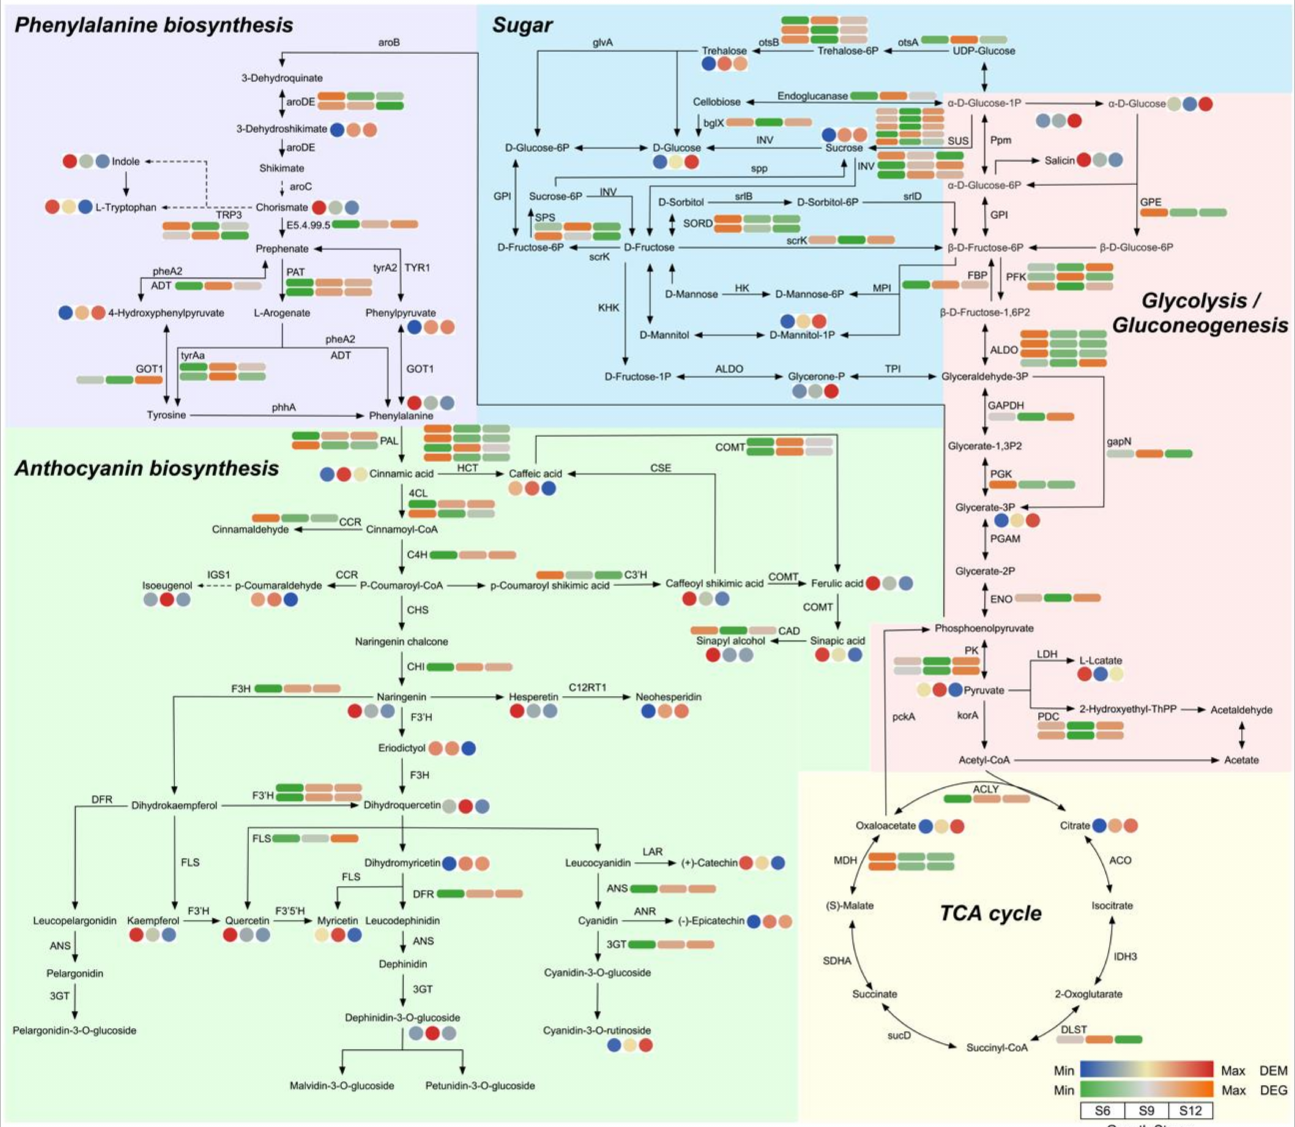
Figure 8. Metabolic pathway analysis centered on glycolysis/gluconeogenesis. The circle and square heatmaps represent the expression of DEMs and DEGs at three developmental stages,